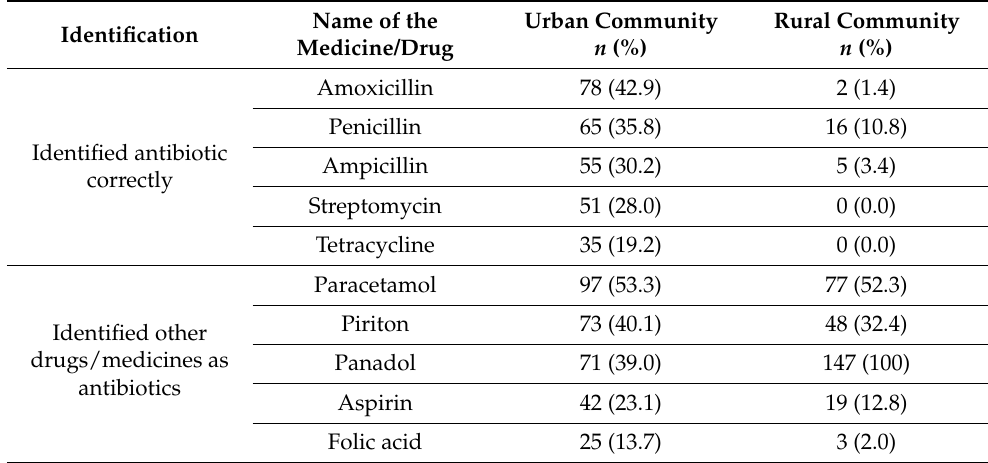
Table 2. Percentages and number of respondents who correctly identified the five antibiotics, and how they incorrectly identified the other five drugs as antibiotics from the given list of 10 commonly used medicines.